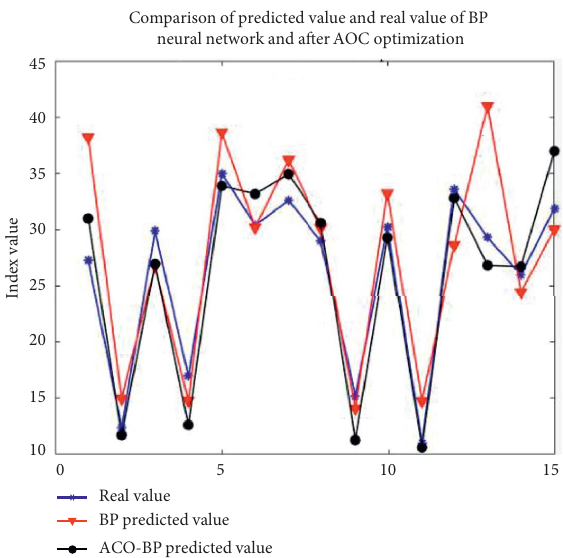
Table 11: Parameter settings of ACO-BPNN. Parameter